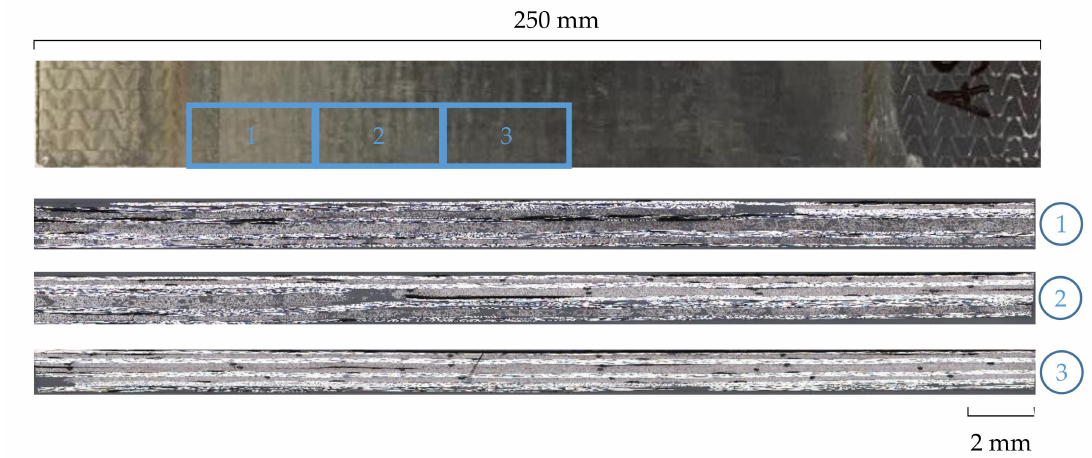
Figure 8. Microscopic cross-sectional views (50 × ) of different regions of a specimen repaired with a UD